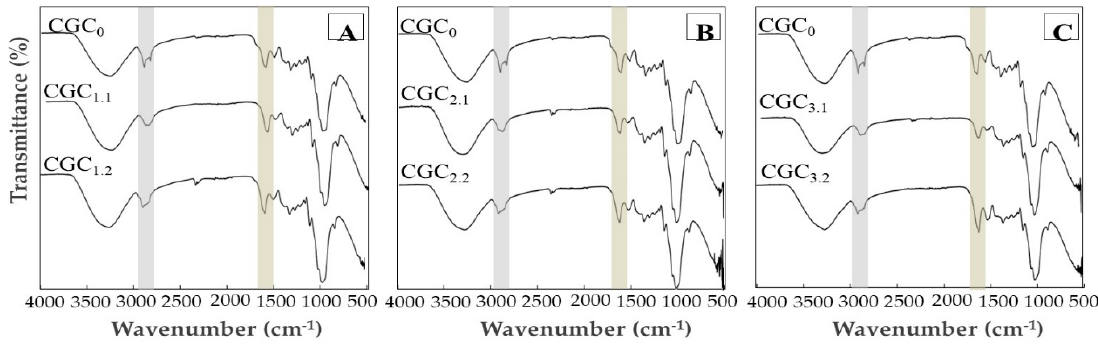
Figure 4. FTIR spectra of CGC 0 and the polymer regenerated from the soluble fractions of CGC in: ( A ) solvent system 1 (CGC 1.1 and CGC 1.2 ), ( B ) solvent system 2 (CGC 2.1 and CGC 2.2 ) and ( C ) solvent system 3 (CGC 3.1 and CGC 3.2 ).